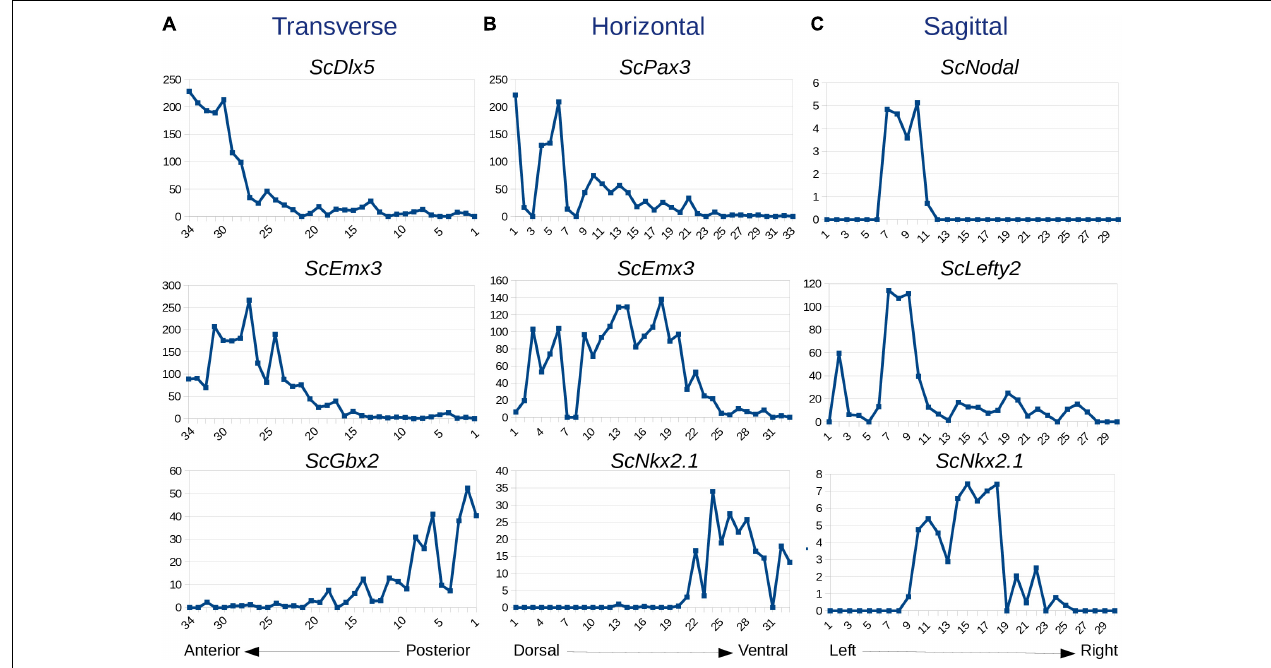
FIGURE 2 | Expression traces for selected genes along transverse (A) , horizontal (B) , and sagittal (C) planes. For each graph, section numbers and corresponding read counts are indicated along x- and y-axes, respectively. Sections 1–34, 1–33, and 1–30 are, respectively, numbered from posterior to anterior in (A) , dorsal to ventral in (B) , and left to right in (C) . Gene names are indicated at the top of each profile.